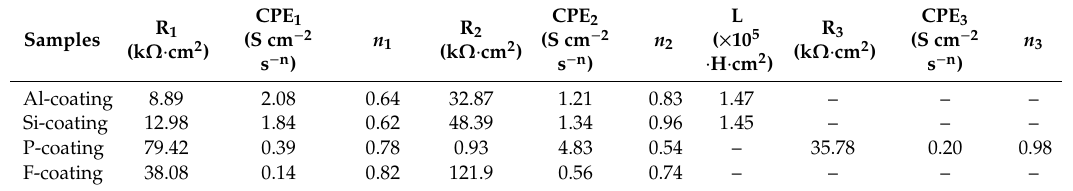
Table 1. Evolution of calculated values of the equivalent circuit elements in Figure